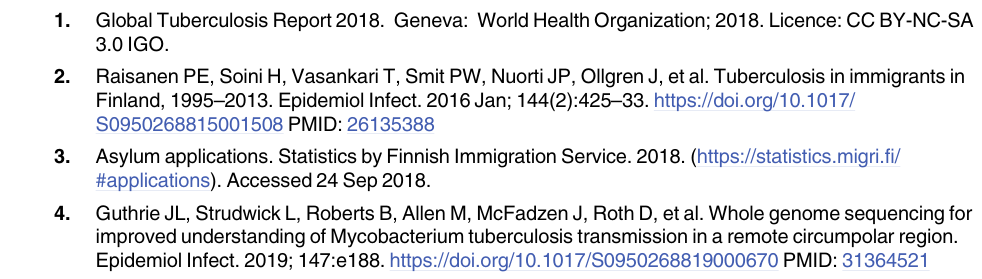
S1 Fig. Phylogenetic tree of the mixed clusters. The tree was generated with Bionumerics 6.6 using the UPGMA (unweighted pair group method with arithmetic mean) method on the cat- egorical values of the similarity matrix of the MIRU-VNTR